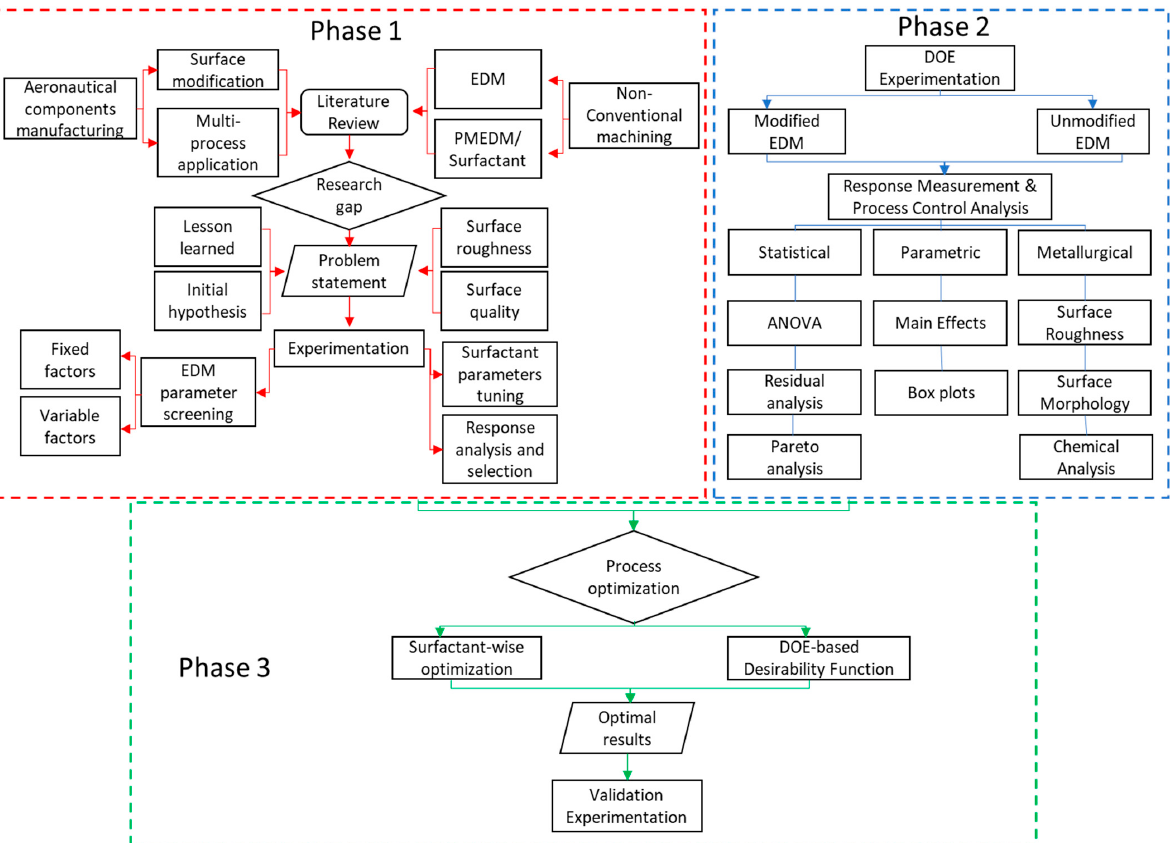
Figure 2. Three-phase experimentation Table 4. Input control parameters for machining of Ti6Al4V.